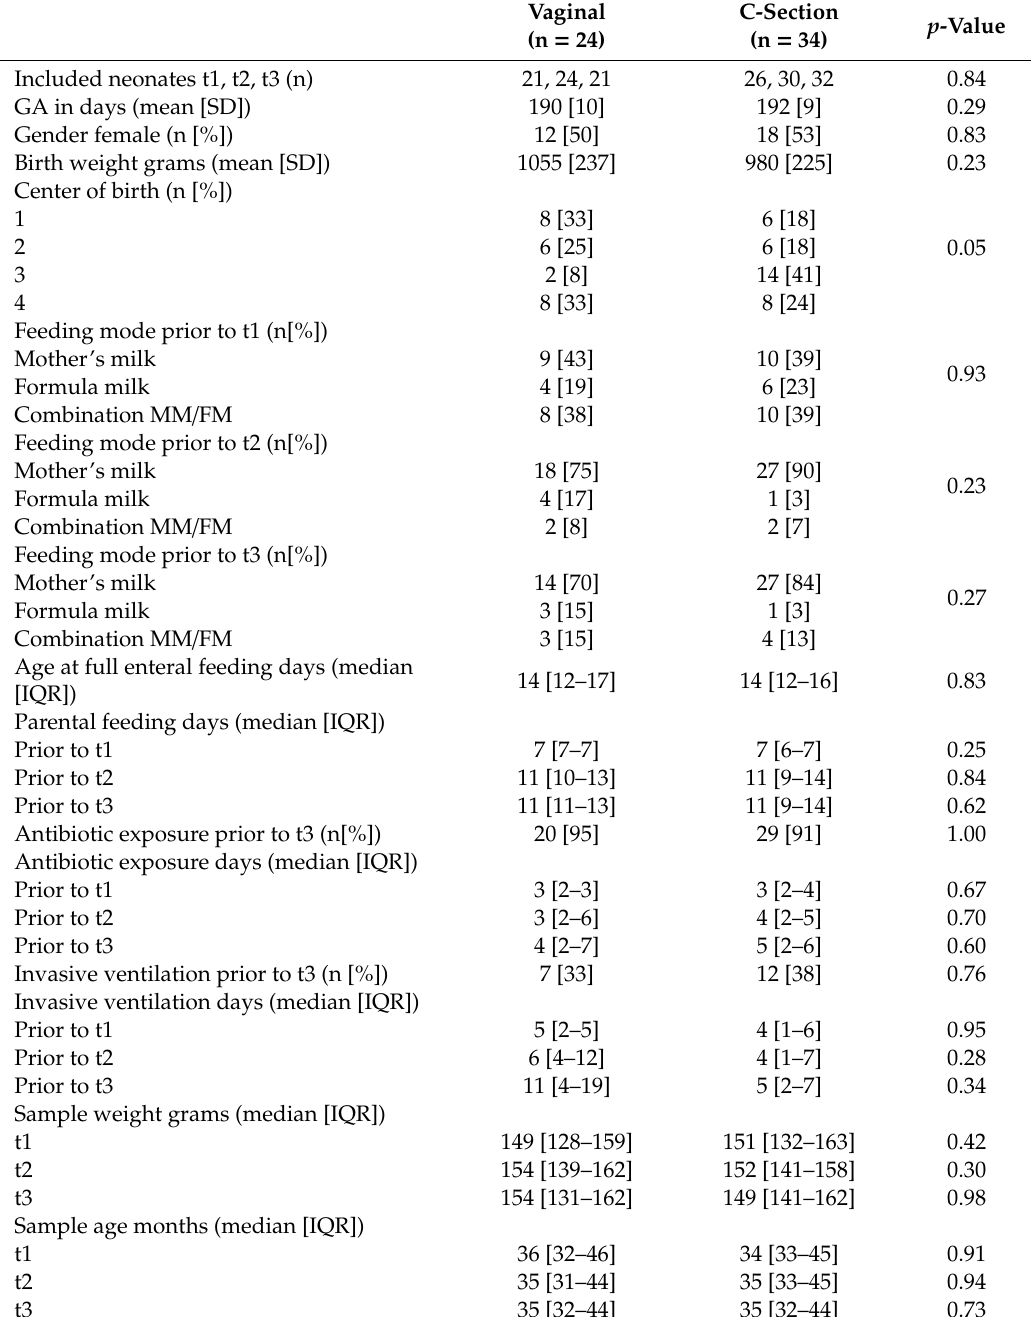
Table 2. Baseline characteristics for infants compared based on birth